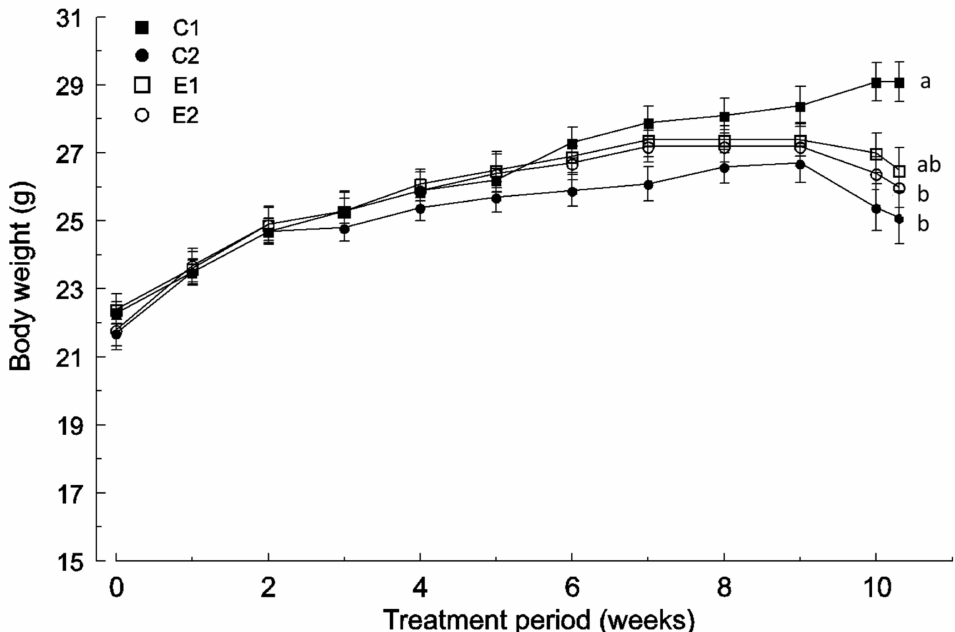
Figure 1. Body weight change in the four experimental groups (mean and SD, n = 12): C1 wild- type mice fed a standard diet, C2 Apc Min/+ fed a standard diet, E1 Apc Min/+ fed a standard diet supplemented with microencapsulated Bf and Lg , E2 Apc Min/+ fed a standard diet supplemented with microencapsulated Bf , Lg, and quercetin. Mean values labeled with unlike letters are significantly different ( p < 0.05; one-way ANOVA was used followed by Tukey’s post hoc